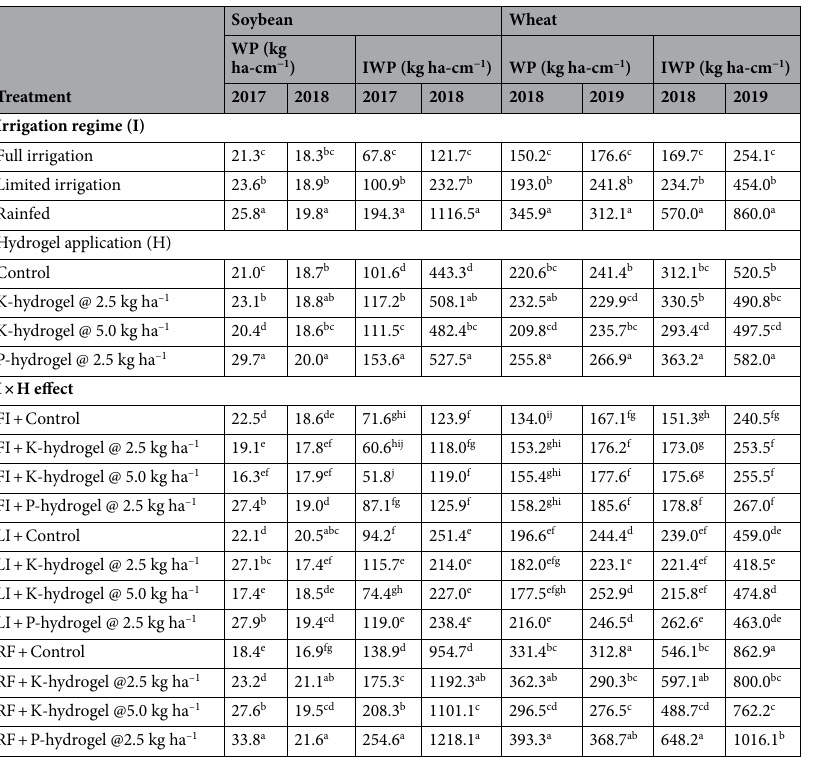
Table 2. Effect of hydrogels and moisture stress conditions on water productivity (WP) and irrigation water productivity (IWP) in soybean–wheat during 2017–19. Means followed by a similar superscript letter within a column are not significantly different (at P ≤ 0.05) between treatments allowing to least significant difference test. Superscripts denotes the superior of the treatments i.e. a denotes best treatment followed by next best treatment b and so on. FI full irrigation, LI limited irrigation, RF